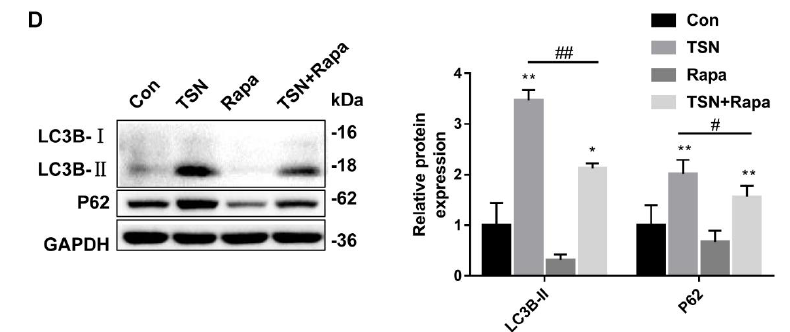
Figure 6. Activation of autophagy alleviated TSN-induced cell damage. HepG2 and L02 cells were treated by TSN (10 μM) with or without Rapa (1 μM) for 24 h. ( A ) (HepG2) and ( B ) (L02) cell viability